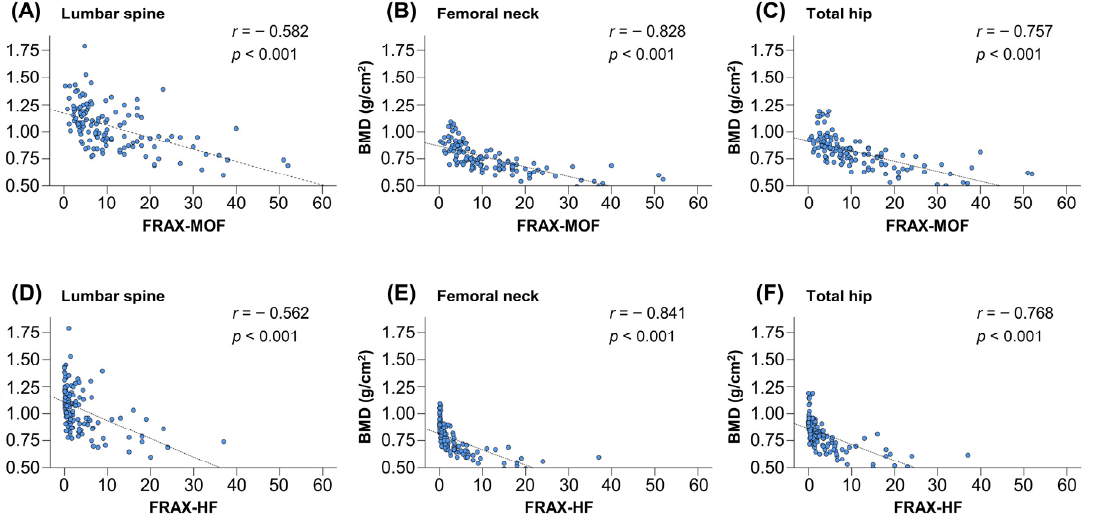
Figure 2. Correlations between bone mineral density (BMD) and the 10-year probabilities of major osteoporotic fracture (FRAX-MOF) and hip fracture (FRAX-HF). The FRAX-MOF was significantly correlated with BMD at lumbar spine ( A ), femoral neck ( B ) and total hip ( C ). The FRAX-HF was significantly correlated with BMD at lumbar spine ( D ), femoral neck ( E ) and total hip ( F ). FRAX, Fracture Risk Assessment Tool. Table 3. Characteristics of the three groups classified based on the baseline IGF-1